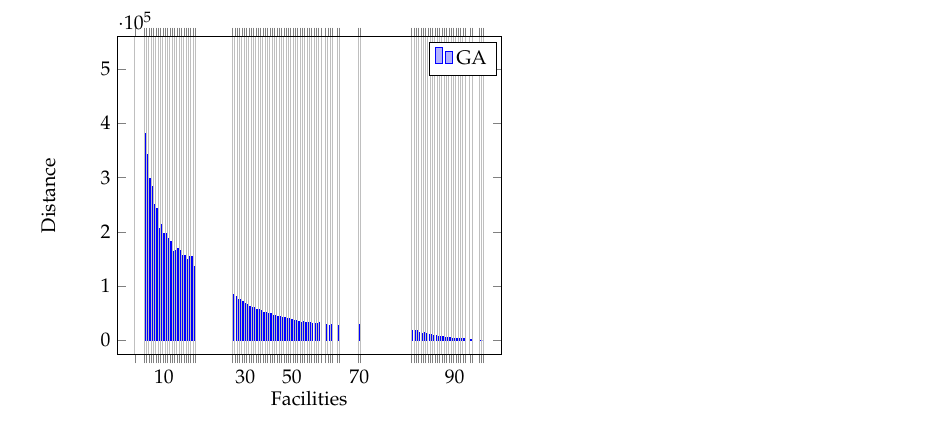
Figure 6. Computed Pareto set for the London dataset using genetic algorithms for a large instance